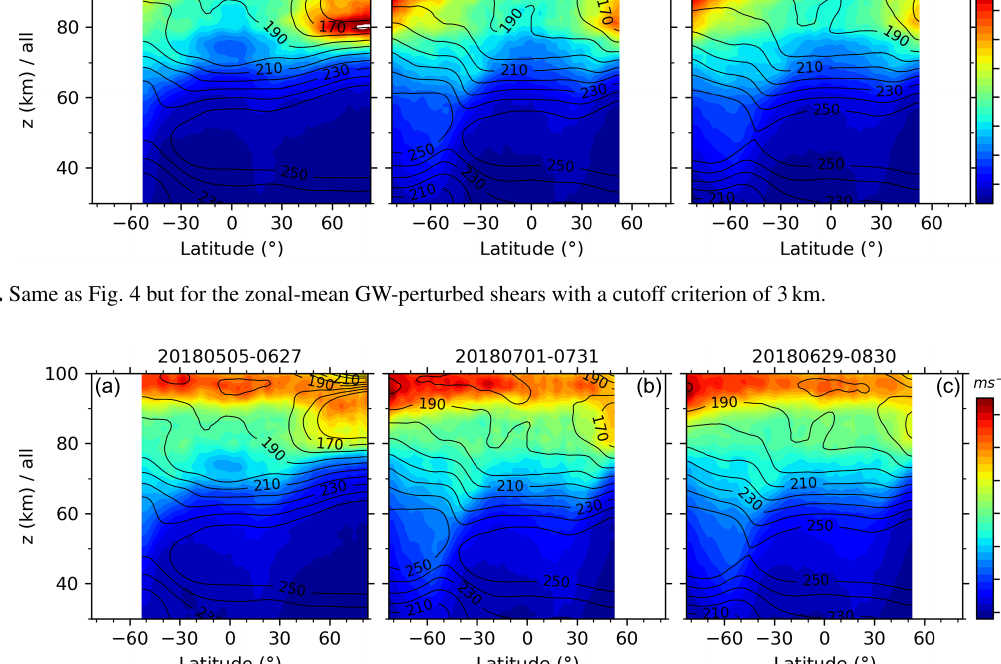
perturbed shears derived with a cutoff criterion of λ z ≥ 3